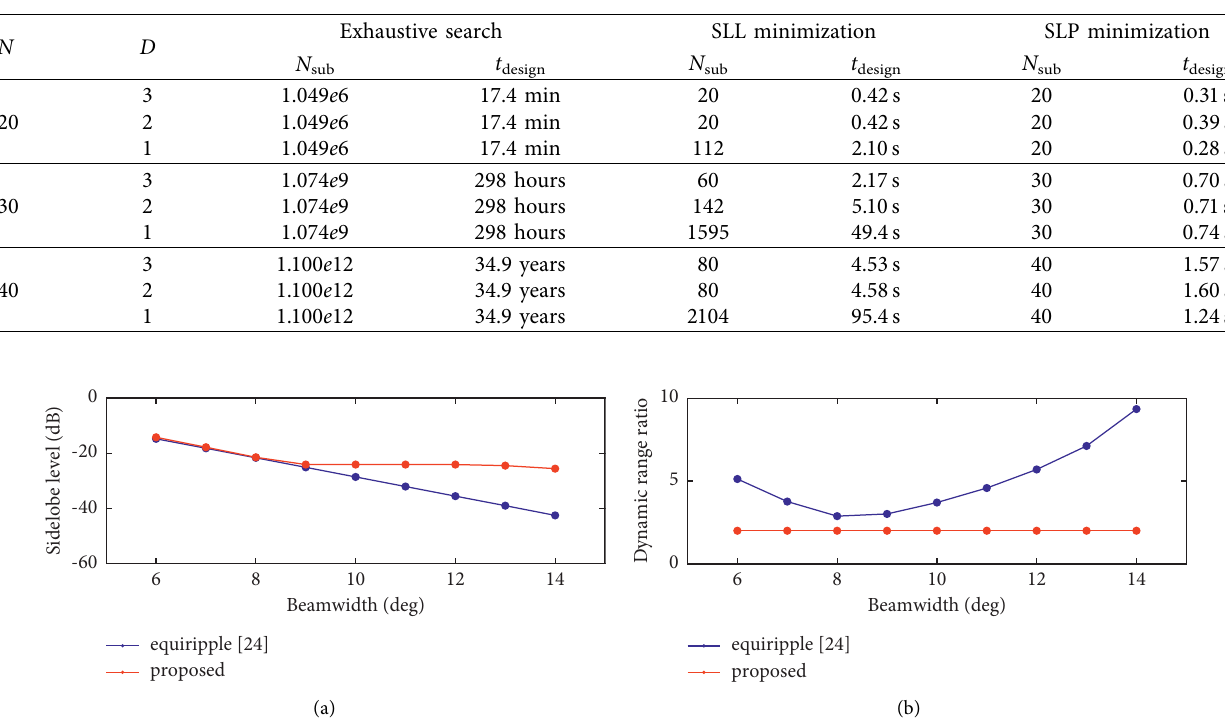
Table 1: Number of subproblems, N sub , and design time, t design , estimated for exhaustive search and obtained in proposed minimization of SLL and SLP for arrays with various numbers of elements, N , DRR constraints, D , and beamwidth of 12 ° . Number of points Q � 10 N and Q � 10 N +1 are used in minimization of SLL and SLP.